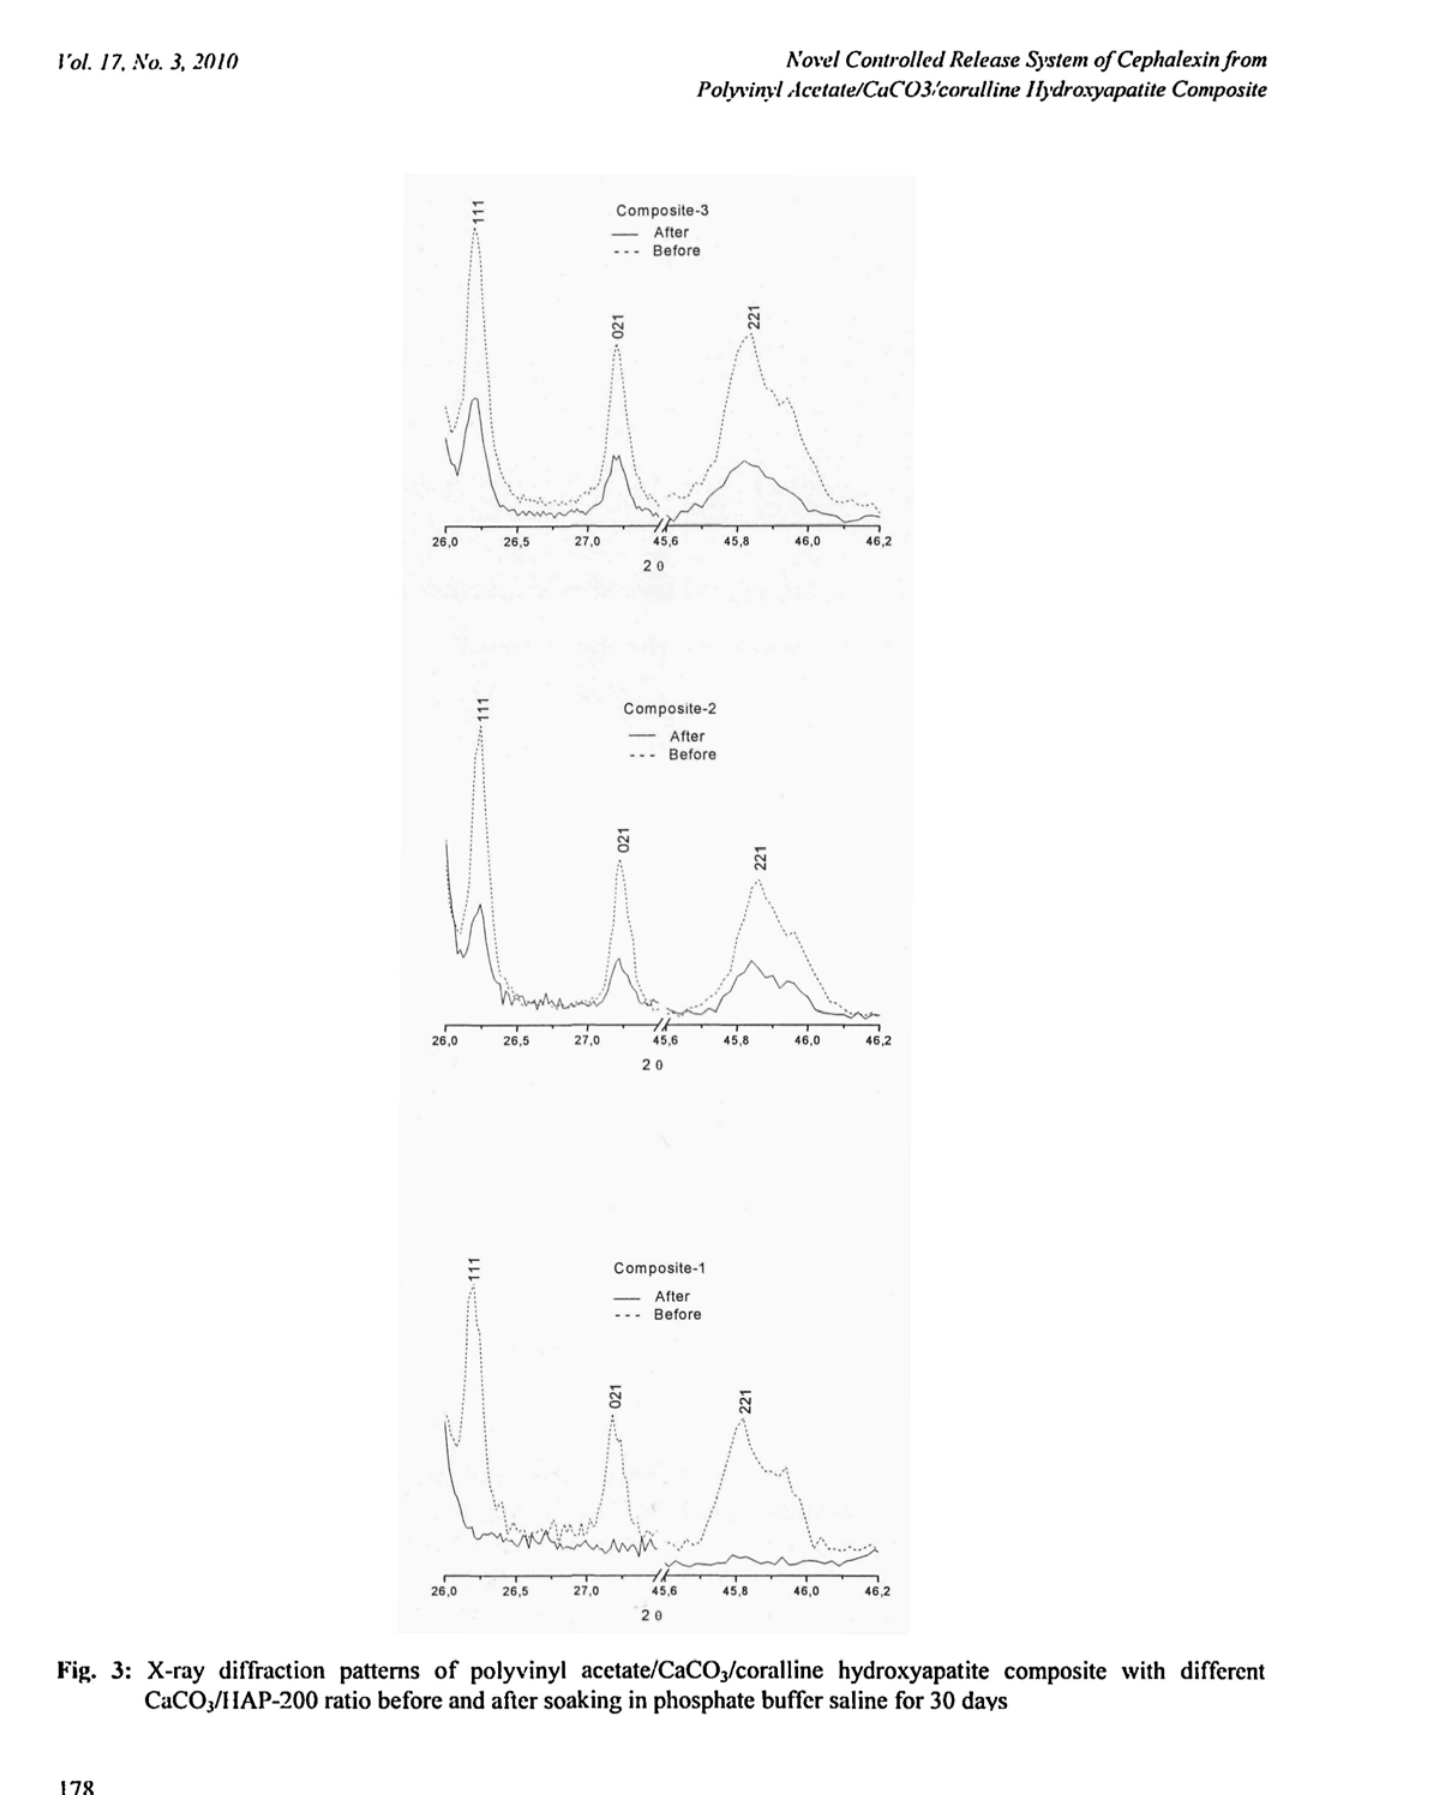
/coralline hydroxyapatite composite with different 3